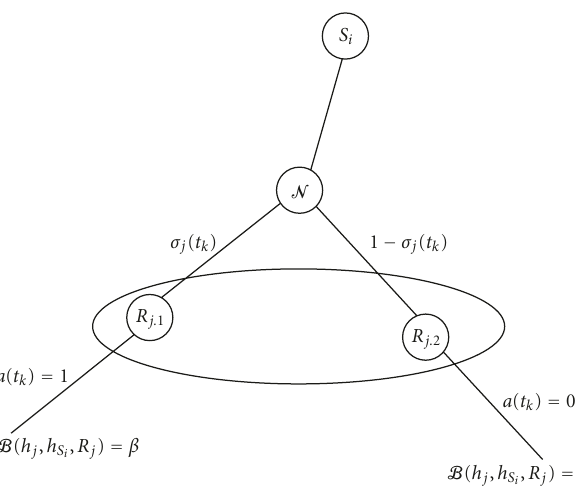
Figure 7: Example 2. Extensive form representation of a cooperative network with imperfect information; R j. 1 , R j. 2 denote the decision nodes in the relay’s information . Note that the incomplete informa- tion of the game has been transformed to imperfect information since we introduce Nature as N which will randomly assigns a decision node to the relay. S i denotes source node i .